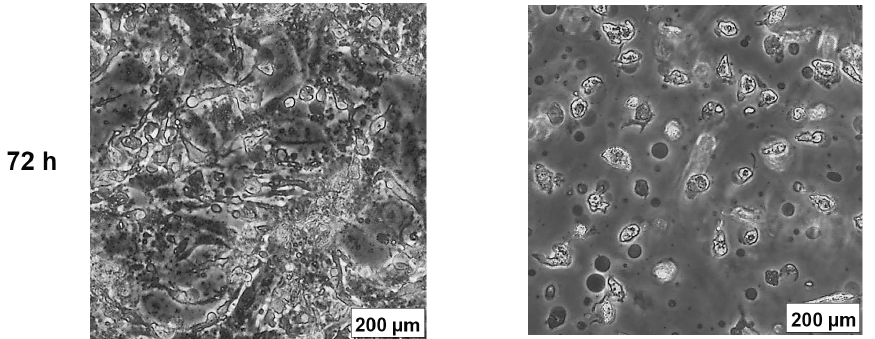
Figure 3. Morphological changes in MCF7 ( A ) and MCF10A ( B ) cells after treatment with aflatoxin B1 from 0–72 h.